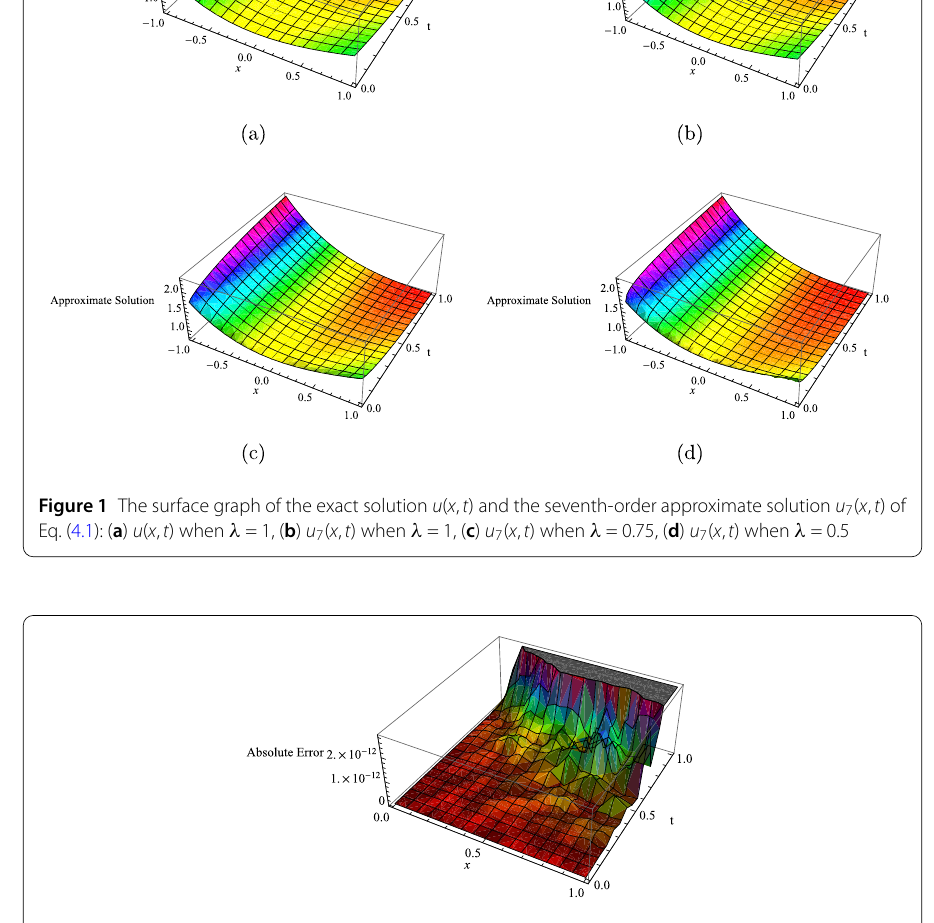
Figure 3 indicates the performance of the approximate solution for different fractional Brownian motions, λ = 0.7,0.8,0.9, and for standard motion i.e. at λ = 1. Figure 4 reflects the (cid:2) curve of Eq. (4.1). As pointed out by Liao [17], we can choose any values of (cid:2) , where (cid:2) ∈ ( (cid:2) 1 , (cid:2) 2 ) and (cid:2) 1 ≈ –1.80, (cid:2) 2 ≈ –0.2. In the particular case if (cid:2) = –1 the speed of convergence is most